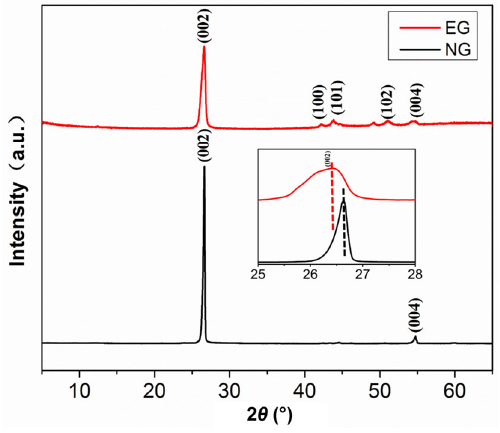
Fig. 1 XRD patterns of NG and